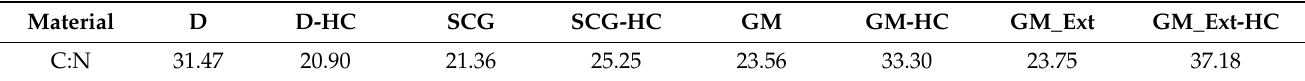
Table 2. C:N ratio of feedstocks and hydrochars.